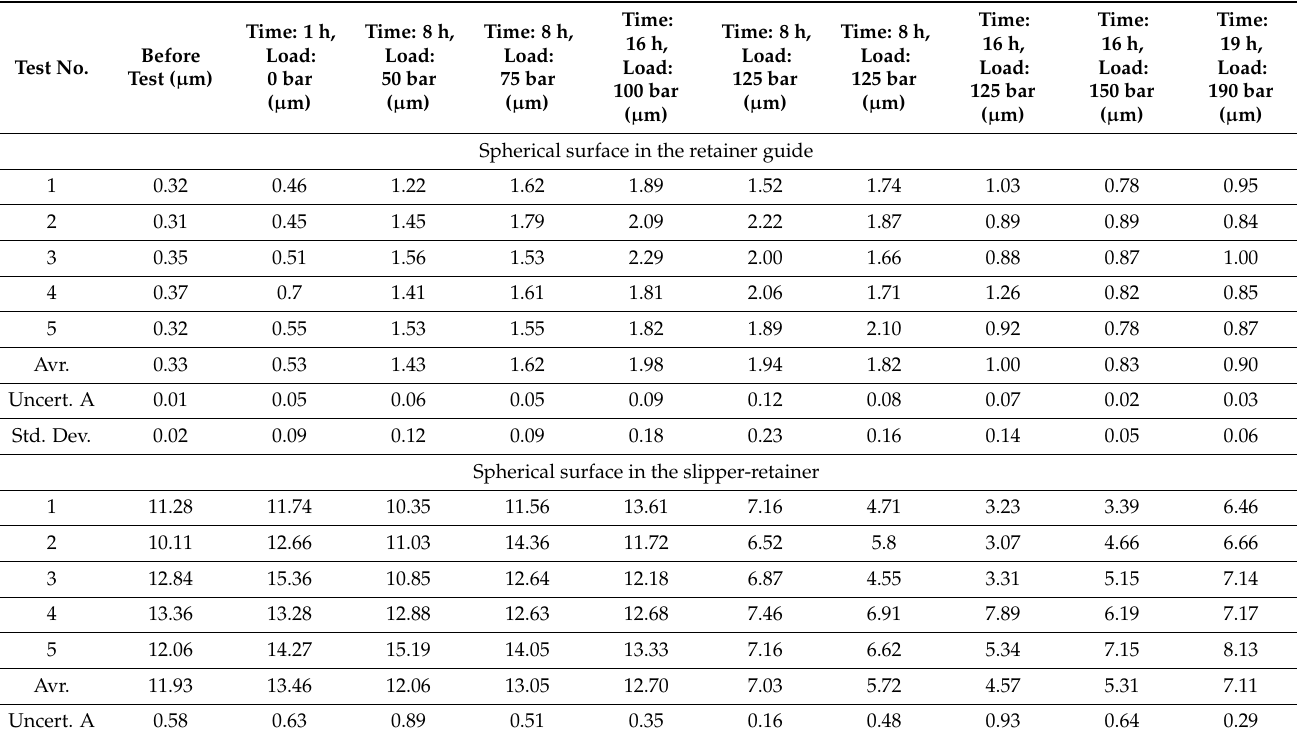
Table 6. Measured values of surface roughness in all tested pump